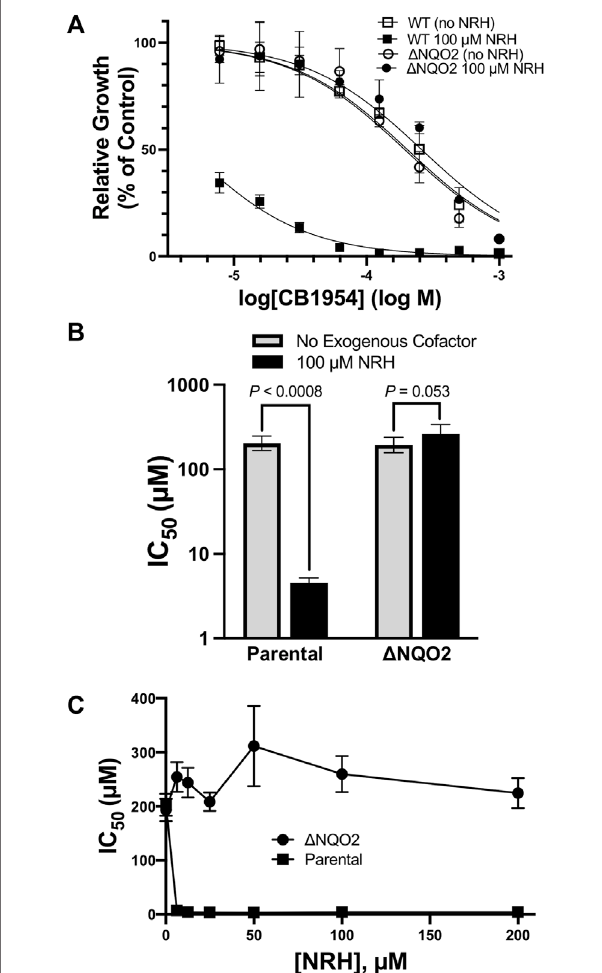
FIGURE 2 | Effect of NQO2 Knockout on CB1954 Toxicity. (A) HCT116 parental (squares) or NQO2 knockouts ( Δ NQO2, circles) were seeded and then grown in varying concentrations of CB1954 in the absence (empty markers) or presence ( fi lled markers) of 100 µM dihydronicotinamide riboside (NRH). Cell growth was measured by SRB assay and normalized to untreated cells; measurements were made in triplicate and the error bars represent 95% con fi dence intervals. (B) IC 50 values in both the absence and presence of 100 µM NRH values cells were derived from the dose-response curves fi tted to the data in (A) . The error bars represent 95% con fi dence intervals; two-tailed t-tests were used to calculate P values for the null hypothesis, namely that the IC 50 values are not signi fi cantly different. (C) Sensitivity of HCT116 parental (squares) and Δ NQO2 (circles) cells to varying concentrations (0, 6, 12.5, 25, 20, 50, 100, and 200 µM) of NRH. Cells were treated as in (A) but with varying NRH concentrations to obtain dose- response curves and IC 50 values. The error bars represent 95% con fi dence intervals. Two-tailed t-tests between the IC 50 for parental cells with no NRH and all of the concentrations of NRH indicate a signi fi cant decrease in IC 50 , with p values consistently less than 0.0008; in contrast, the effect of NRH on theNQO2knockoutsappearstoresultinaslightincreaseinIC 50 ,althoughthe P values are less signi fi cant, ranging from p ≈ 0.05 (at 6.25, 50, and 100 µM NRH) to p = 0.11, 0.58, and 0.41 at 12.5, 25, and 100 µM